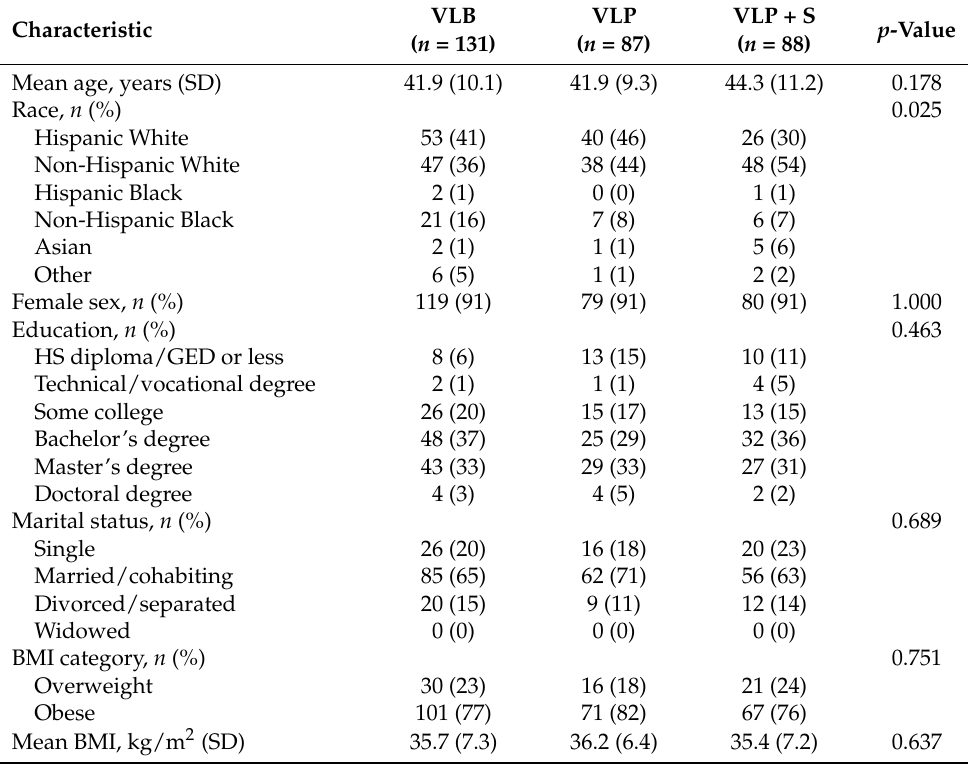
Table 4. Baseline characteristics of participants among intervention groups ( n =